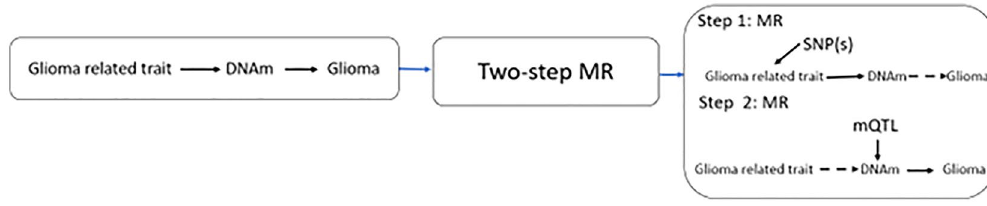
Figure 7. A summary of hypothesis 2: Does DNA methylation (DNAm) influence both glioma related traits and glioma risk? MR, Mendelian randomization; mQTL, methylation quantitative trait loci; SNP, single nucleotide polymorphism.